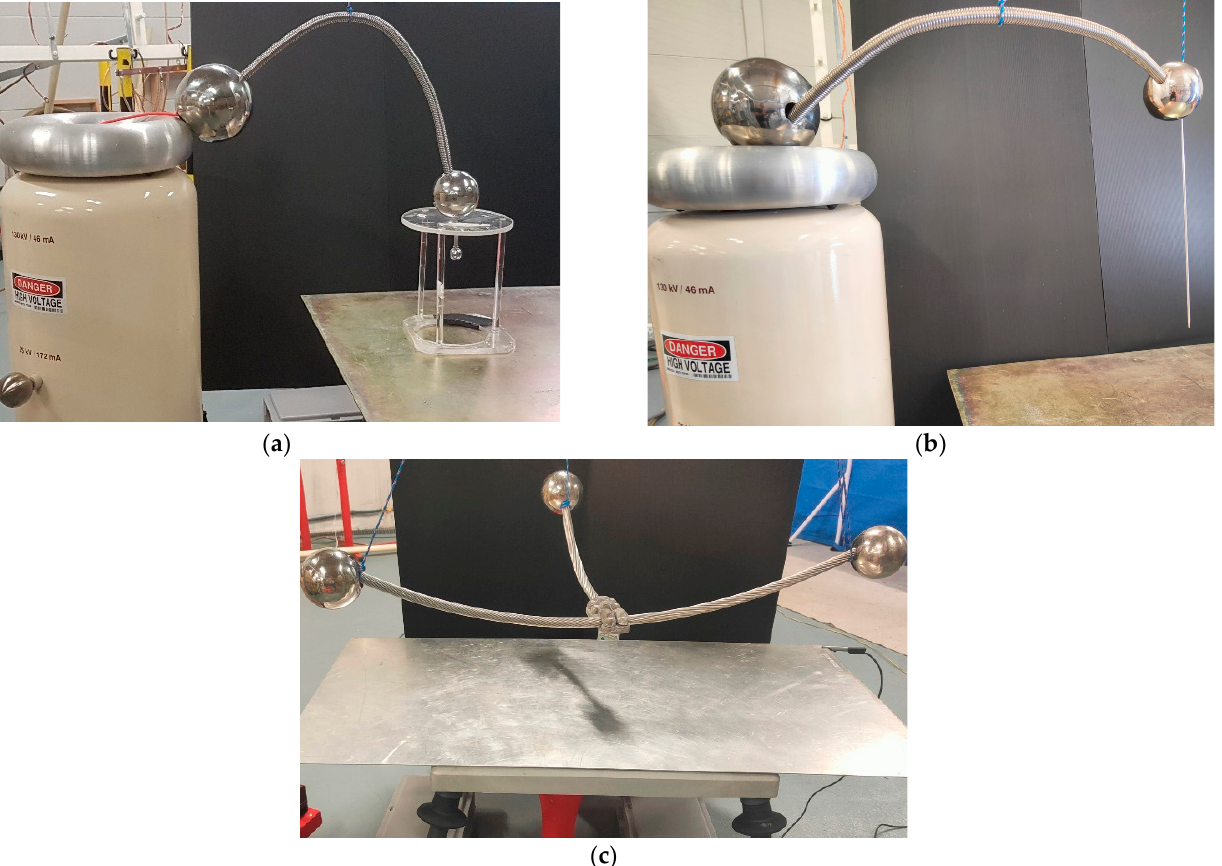
Figure 4. Test objects that were utilized to generate the corona discharges. ( a ) Sphere-plane gap (diameter = 22 mm, height above ground plane = 150 mm). ( b ) Needle-plane gap (curvature radius = 0.5 mm, slant angle = 12°, height above ground plane = 130 mm). ( c ) Substation connector (height above ground plane = 200 mm).